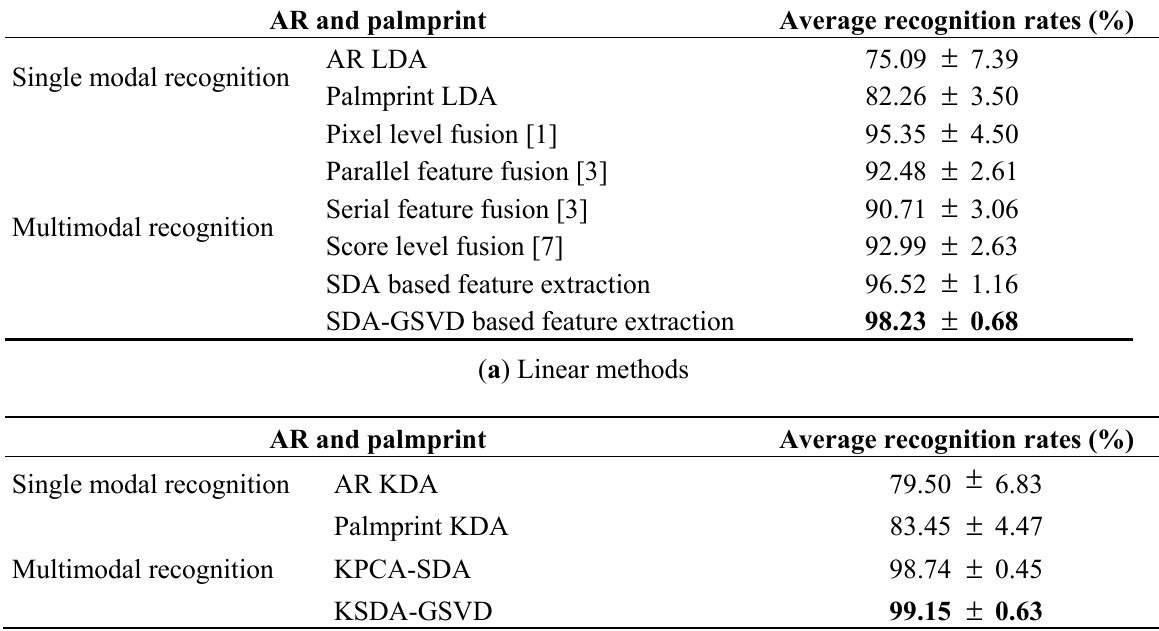
Table 1. Average recognition rates of compared methods on AR face and PolyU palmprint